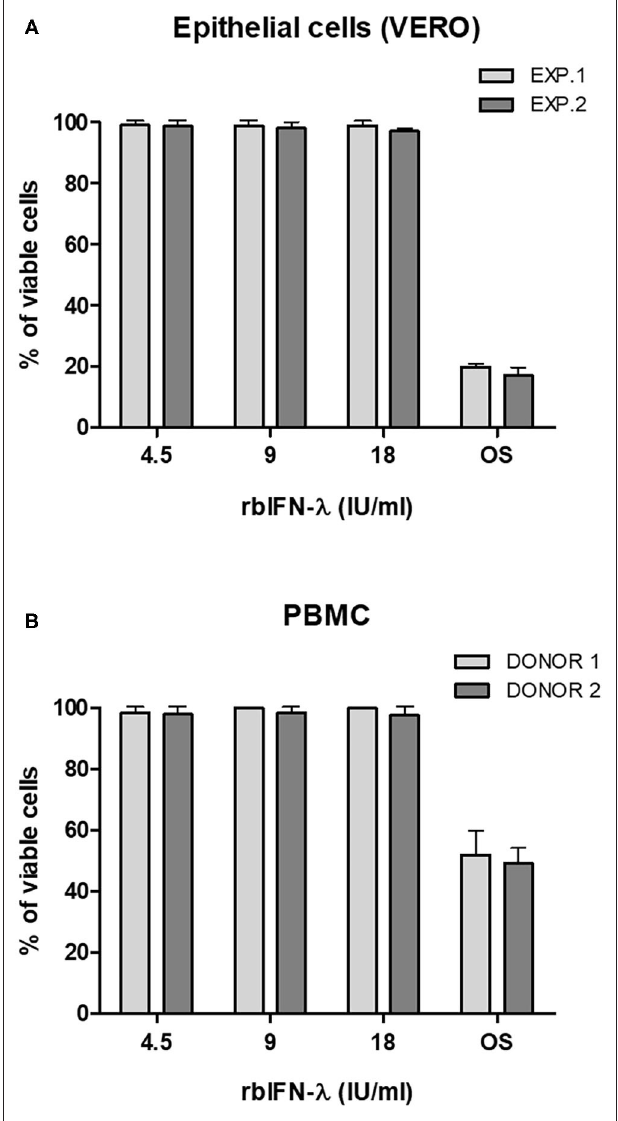
FIGURE 2 | Effect of the bovine rIFN- λ on the viability of VERO cells and human PBMCs. VERO cells (A) and PBMCs (B) were treated with 4.5, 9, and 18 IU/ml of recombinant bovine IFN- λ (rbIFN- λ ) for 18h and their capacity to reduce XTT was assessed. Control cell samples were also incubated ON with PBS to induce an osmotic shock (OS). Percentage of living cells was referred to values of mock-treated controls. Mean values ± SD from triplicate samples are depicted for each dilution for each experiment (EXP.) or human donor.